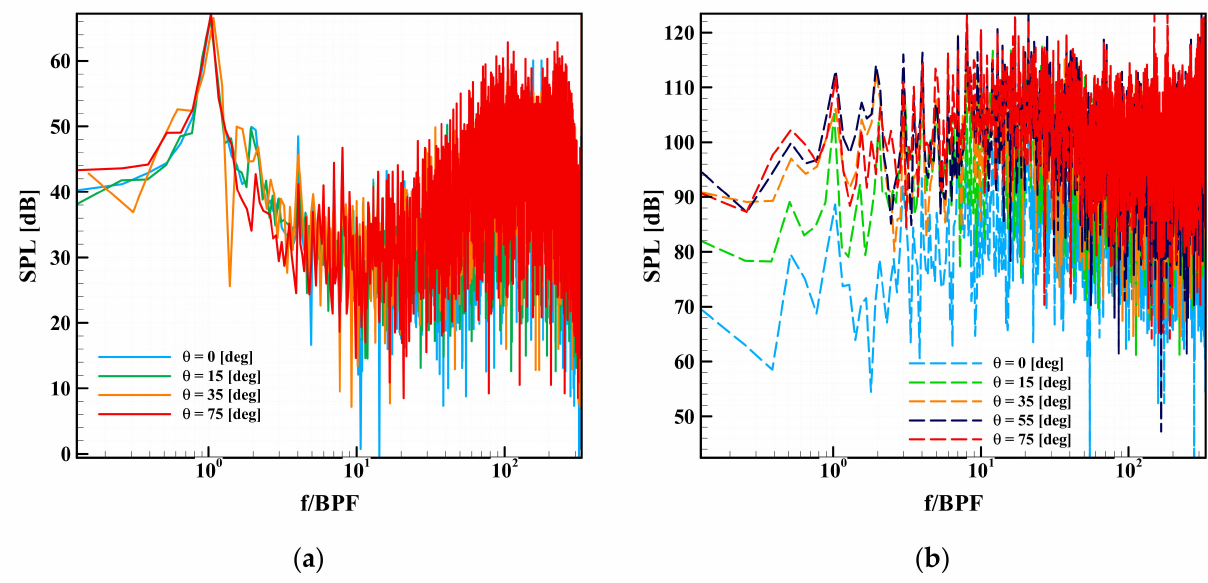
Figure 8. SPL spectra at BPF, downstream: ( a ) isolated propeller; ( b )